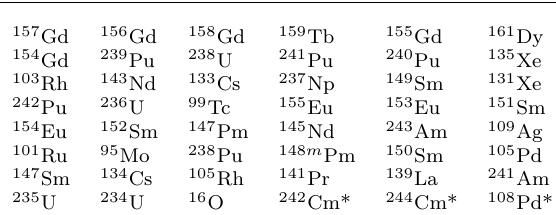
Table 2. Nuclides with big impact on the